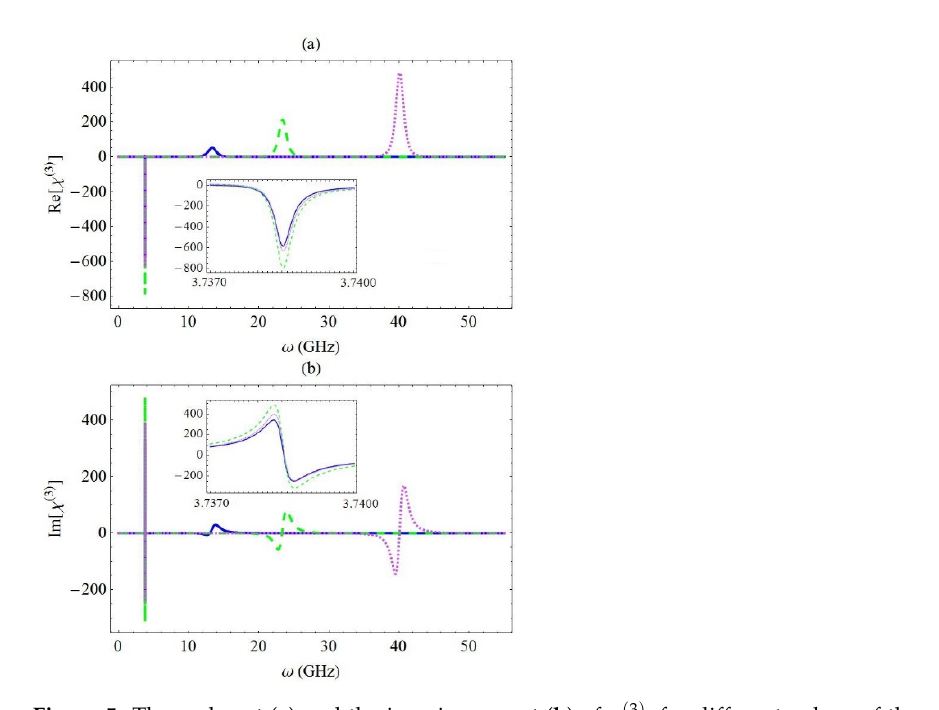
/ ω ω ω= + n g , were both proportional to the square of